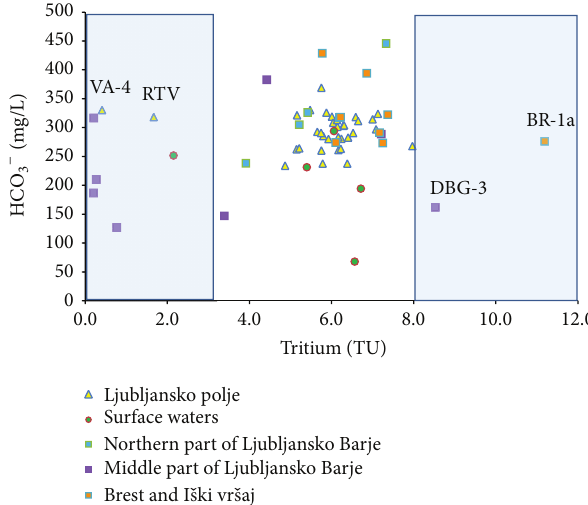
Figure 10: Relationship between HCO 3− and tritium in groundwa- ter of Ljubljansko polje and Ljubljansko Barje aquifers.